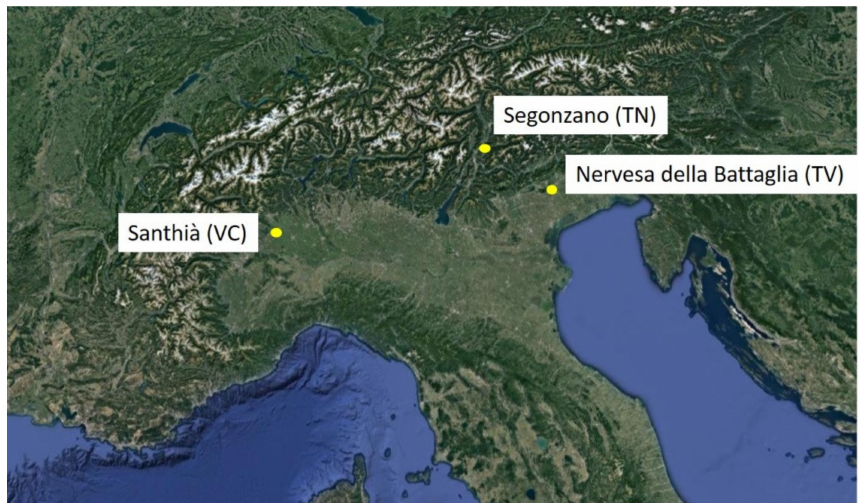
Figure 1. Map of the three different sampling sites colored in yellow, located in the north of